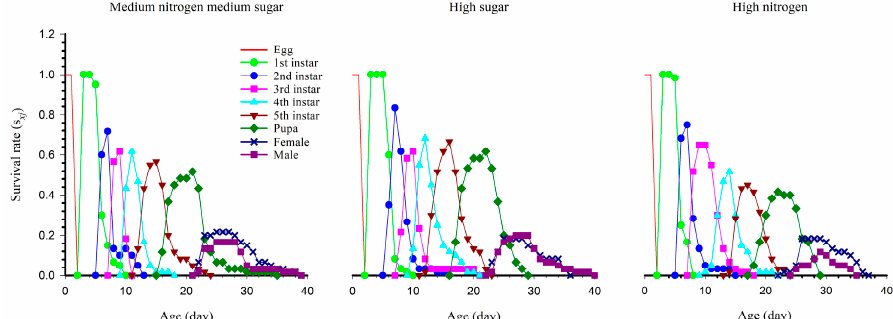
Figure 1. The age-stage survival rate ( s xj ) of S. exigua under three nutritional conditions .